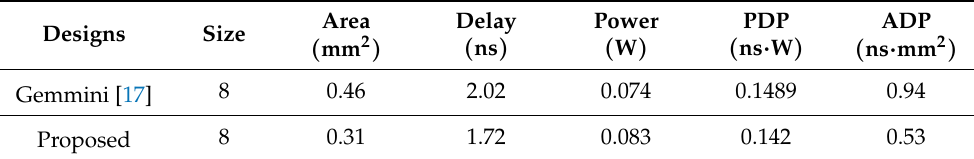
Table 2. Implementation results for 8 × 8 Gemmini [17] and proposed CPA-Factored Gemmini systolic arrays (SAs).